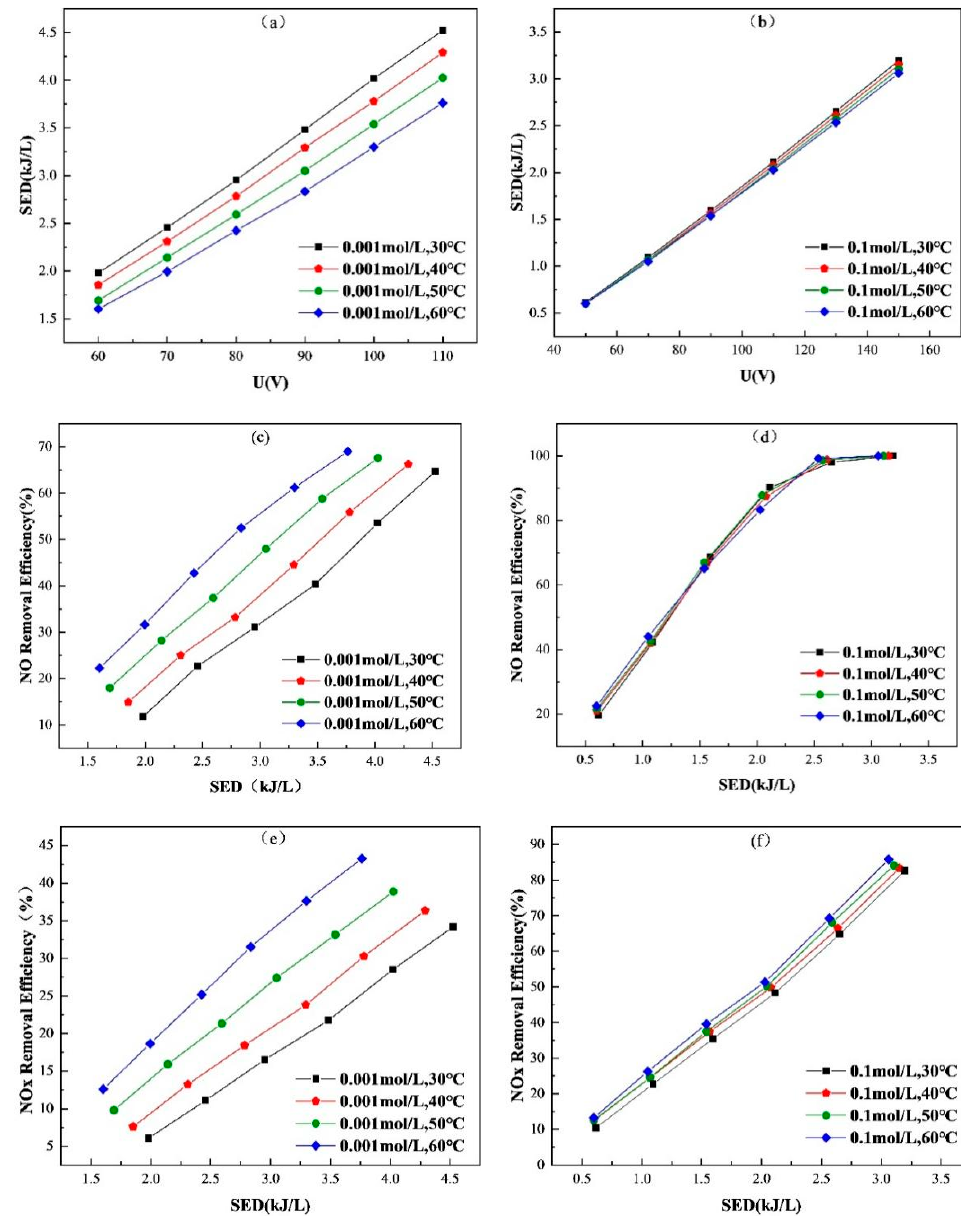
Figure 8. The influence of gas temperature and KCL solution concentration on NO/NOx removal efficiency: ( a ) The SED changes with input voltage at 0.001 mol/L; ( b ) The SED changes with input voltage at 0.1 mol/L; ( c ) NO removal efficiency at 0.001 mol/L; ( d ) NO removal efficiency at 0.1 mol/L; ( e ) NOx removal efficiency at 0.001 mol/L, and ( f ) NOx removal efficiency at 0.1